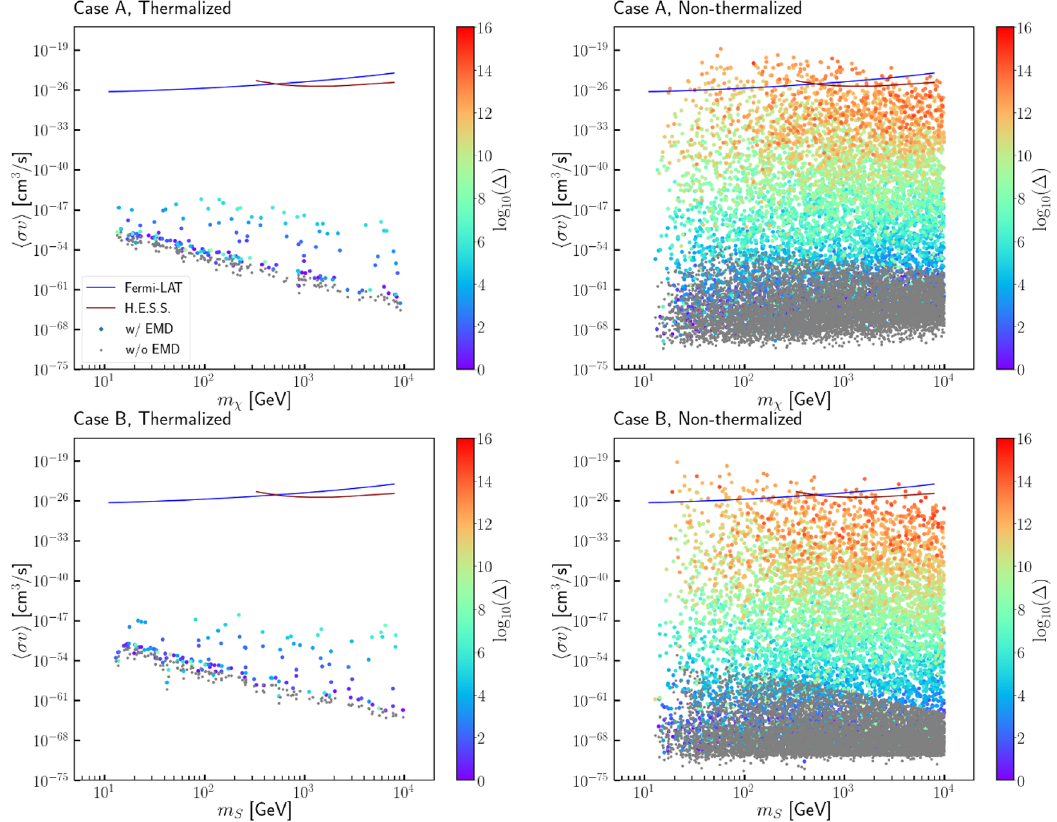
Figure 11 . The annihilation cross section of the dark matter into heavy neutrino with (color- coded points) and without (grey points) EMD for both Case A (upper panels) and Case B (lower panels), as a function of the dark matter mass, m (cid:31) . Each point provides the observed DM relic density, under the freeze-in regime. The color bar indicates the value of the dilution factor (cid:1) (eq. (3.17)), with increasing values corresponding to longer EMD era scenarios. The heavy neutrino is considered to be thermalized (left panels) and non-thermalized (right panels) respectively. The blue and red lines indicate the constraints from Fermi-LAT and H.E.S.S. respectively [95]. which, in turn, avoid the thermalization of heavy neutrinos, can already be tested by